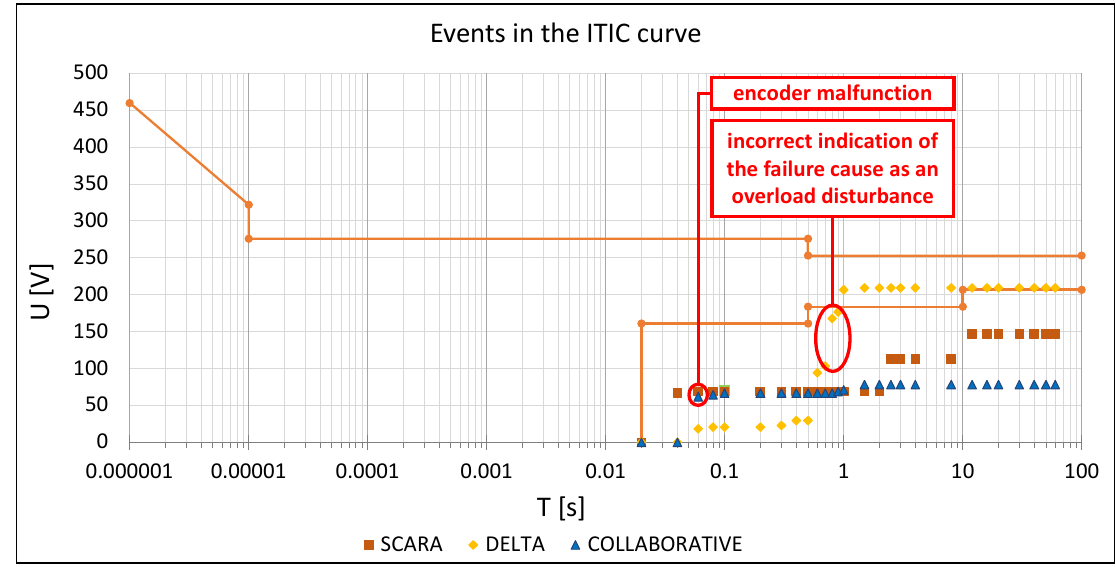
Figure 5. Disturbances in the correct operation of selected tested robots against the background of ITIC characteristics (in the region marked in ITIC/SEMI F47 as being free from destructive states, states leading to the destruction of the receiver have been identified).